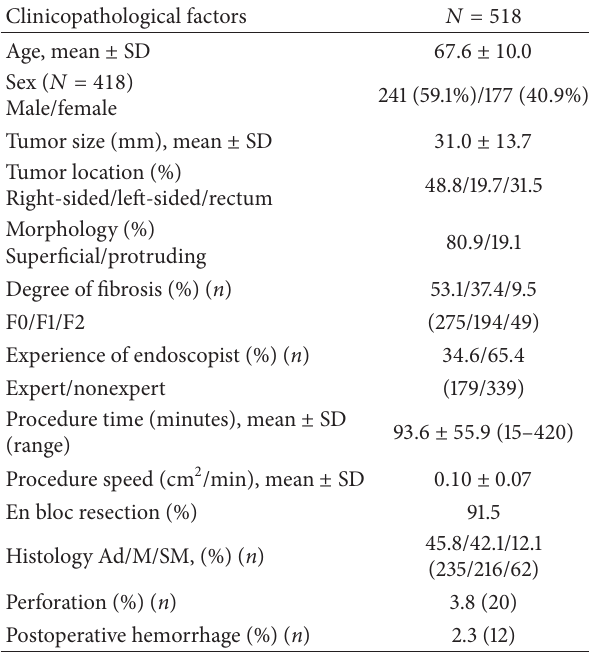
Figure 1: Classification about fibrosis of the submucosal layer F0: no fibrosis, manifested as a blue transparent layer, F1: mild fibrosis that appears as a white web-like structure in the blue submucosal layer, and F2: severe fibrosis that appears as a white muscle-like structure without a blue transparent layer in the submucosal layers. Table 1: Clinical characteristics and outcomes of colorectal